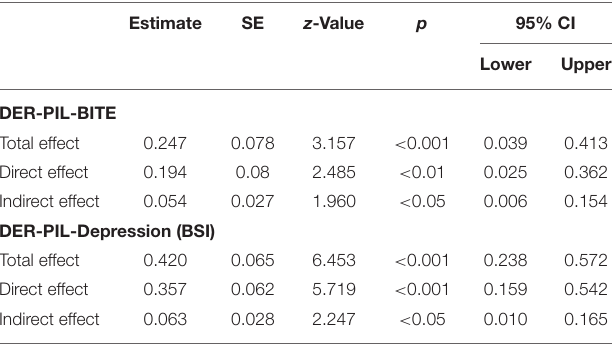
TABLE 5 | Multiple mediation model of meaning in life between emotional dysregulation and the bulimic and binge eating disorders symptoms and depression in participants with obesity.